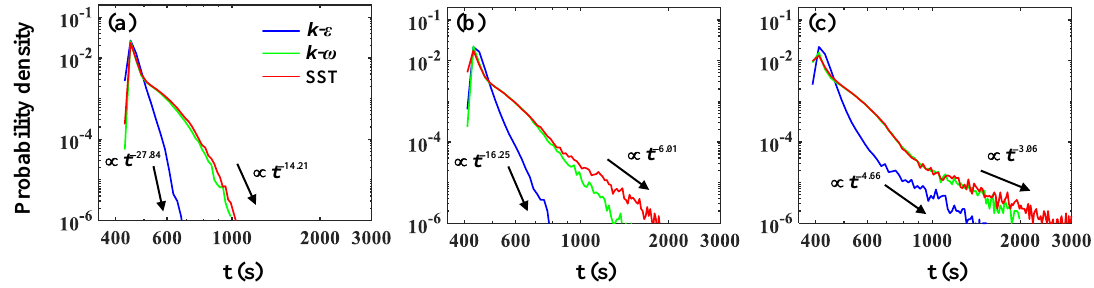
Figure 9 . Impact of turbulence models on 1D breakthrough curves of ( a ) S136, ( b ) S157, and ( c ) S190.